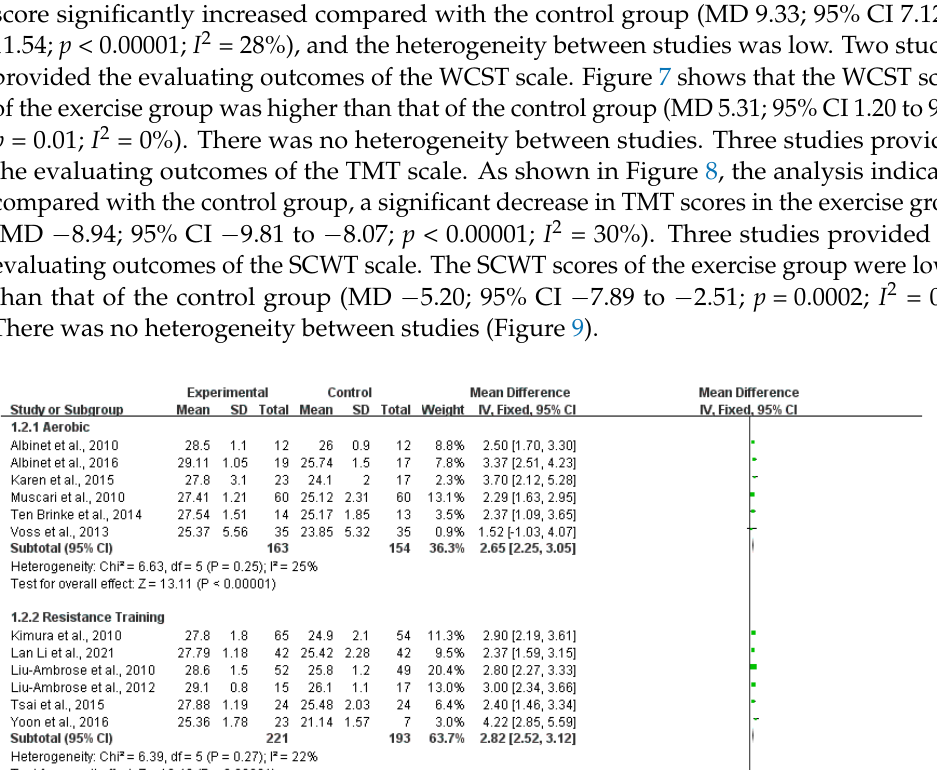
Int. J. Environ. Res. Public Health 2023 , 20 , x FOR PEER REVIEW